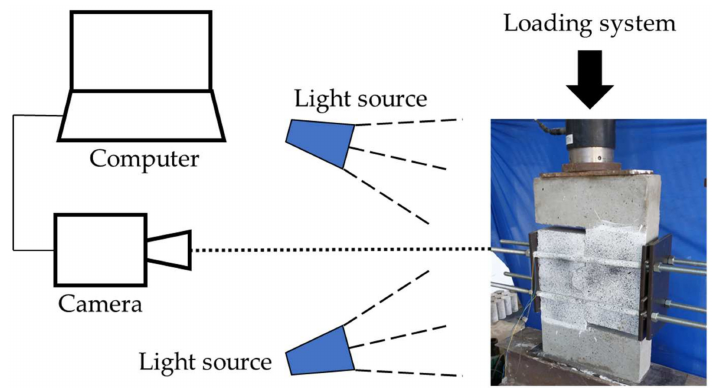
Figure 11. Single-keyed specimen with installed the confining system and DIC setup.